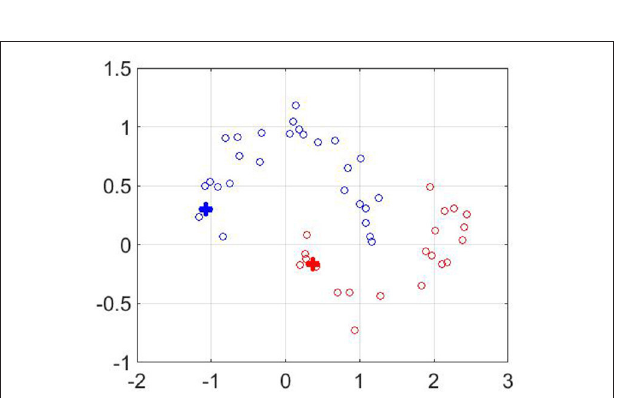
FIGURE 1 | Classification of “two moons” dataset with extrapolation region. The values of parameters are m =2, ǫ 0 = 1, q =0.9, λ ( thr ) 2 = 10 − 6 .